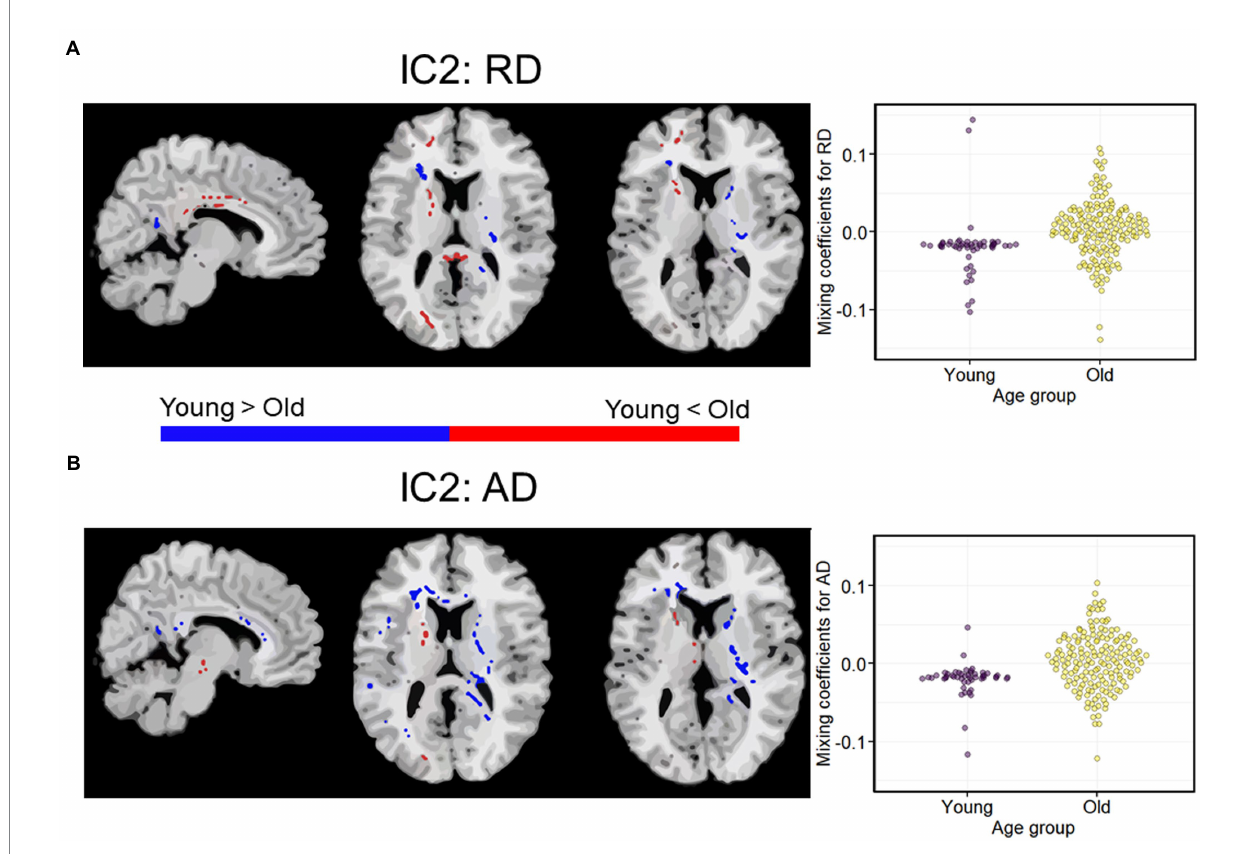
FIGURE 2 A modality-shared independent component (IC2) differentiating younger and older adults via independent samples t-test on mixing coefficients. (A) Spatial maps for RD. (B) Spatial maps for AD. When z scores (red voxels) are positive and mixing coefficients are positive, the component is showing increased RD/AD in older adults. Conversely, when z -scores are negative (blue voxels) and mixing coefficients are positive, the component is showing increased RD/AD in young adults. Density plots show the loading parameters (or mixing coefficients) of IC2 for both RD and AD feature maps. Higher mixing coefficients for both RD and AD in older adults means that IC2 was expressed more in older adults. All the two-sample t -tests between young and older adults had p < 0.01. IC, independent